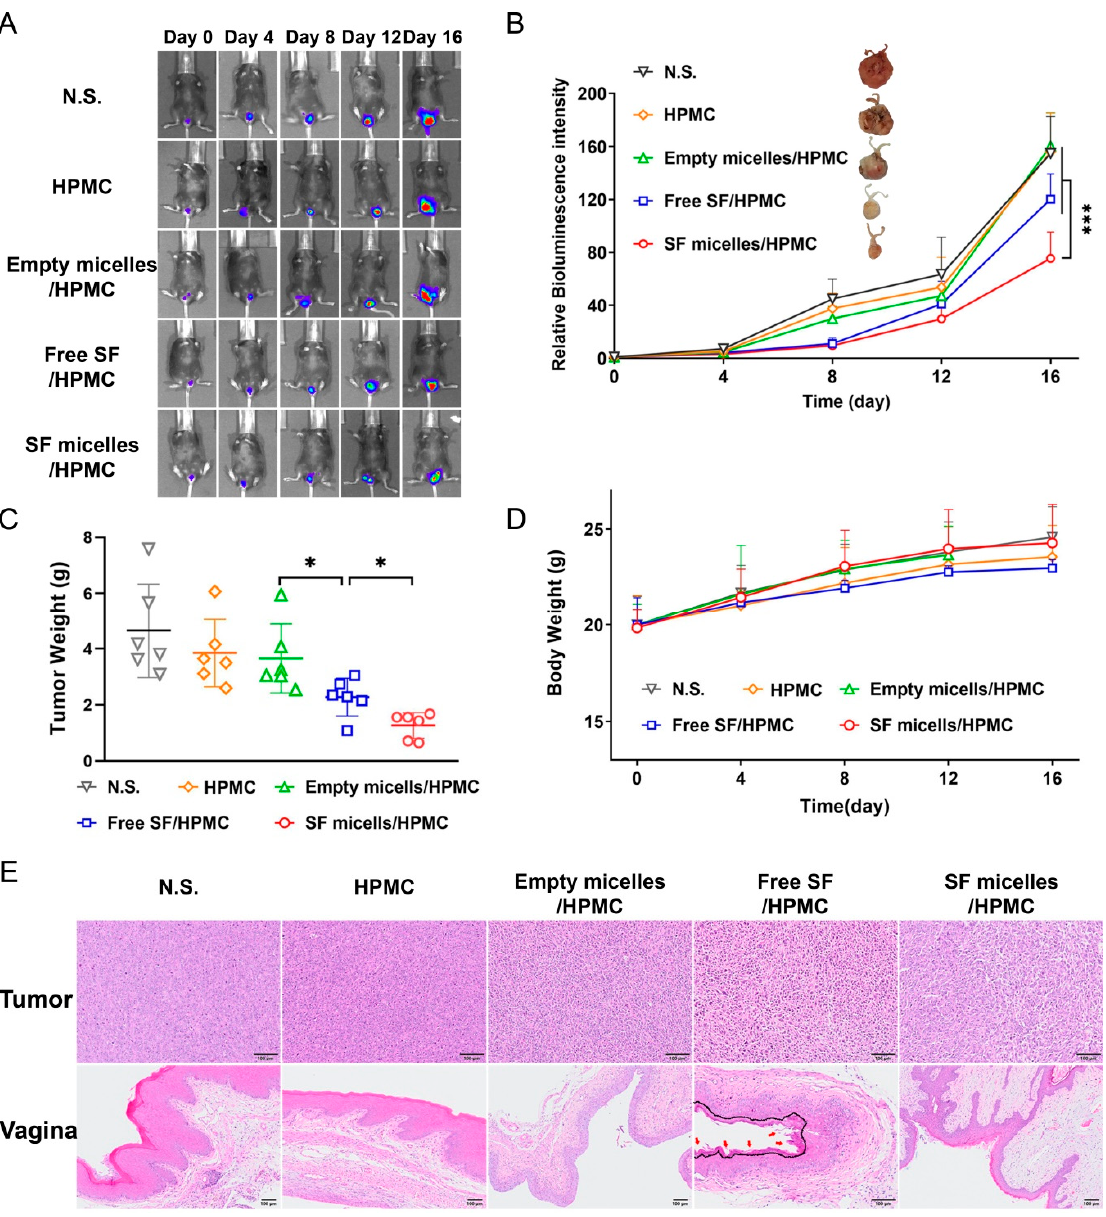
Figure 7. Anti-tumor efficacy of SF micelles/HPMC treatment by intravaginal administration at a dose of 15 mg/kg in every 3 days for 16 days. ( A )Typical bioluminescence images in orthotopic cervical cancer model tumor-bearing mice after intravaginal administration of different formulations at the 0th, 4th, 8th, 12th and 16th day. ( B ) Relative bioluminescence intensity of tumors (Insert: Typical photographs of orthotopic cervical model tumors by the end of treatment). ( C ) Tumor weights at the end of treatment (n = 6, mean ± SD). ( D ) Body weights vs. time curves (n = 6, mean ± SD). ( E ) Representative H&E microphotographs of tumors and vagina. Scale bars = 100 μ m. Significance criteria: * p < 0.05, *** p < 0.001.